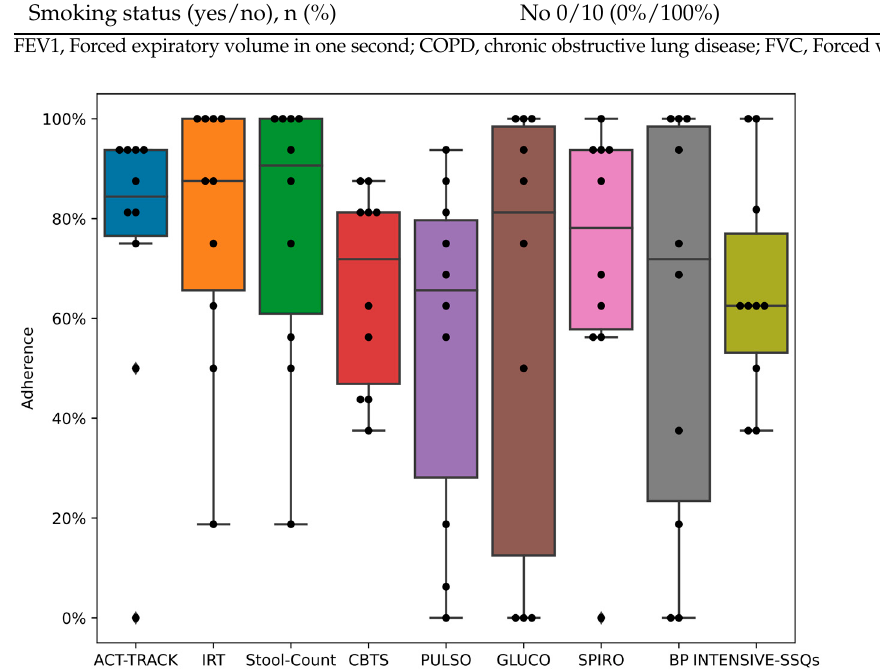
Figure 4. Adherence to monitoring modalities heatmap for both monitoring periods combined (the 1st and 2nd vaccination) for the whole study population. Green ‐ color fields indicate very high ad ‐ herence, yellow fields indicate moderate adherence and brown fields indicate low adherence. On the x ‐ axis, the days after vaccination are presented for intensive monitoring phase, i.e., the first 8 days, while the y ‐ axis corresponds to modalities. Adherence to INTENSIVE ‐ SSQs means that all questions were answered. Abbreviations: PULSO: PULSOoximeter; CBTS: Core Body Temperature Sensor; ACT ‐ TRACK: ACTivity ‐ TRACKer; IRT: InfraRed Thermometer; INTENSIVE ‐ SSQs: Inten ‐ sive Symptom and Sign Questionnaires; SPIRO: SPIROmeter; BP: Blood Pressure; GLUC: GLU ‐ COmeter. Most symptoms and signs of health and disease were transferred via the COVIDA desk GSM connection to the study team daily. The symptom frequency and e ‐ health mon ‐ itoring parameters are summarized in Figure 5. The most frequent symptoms after two